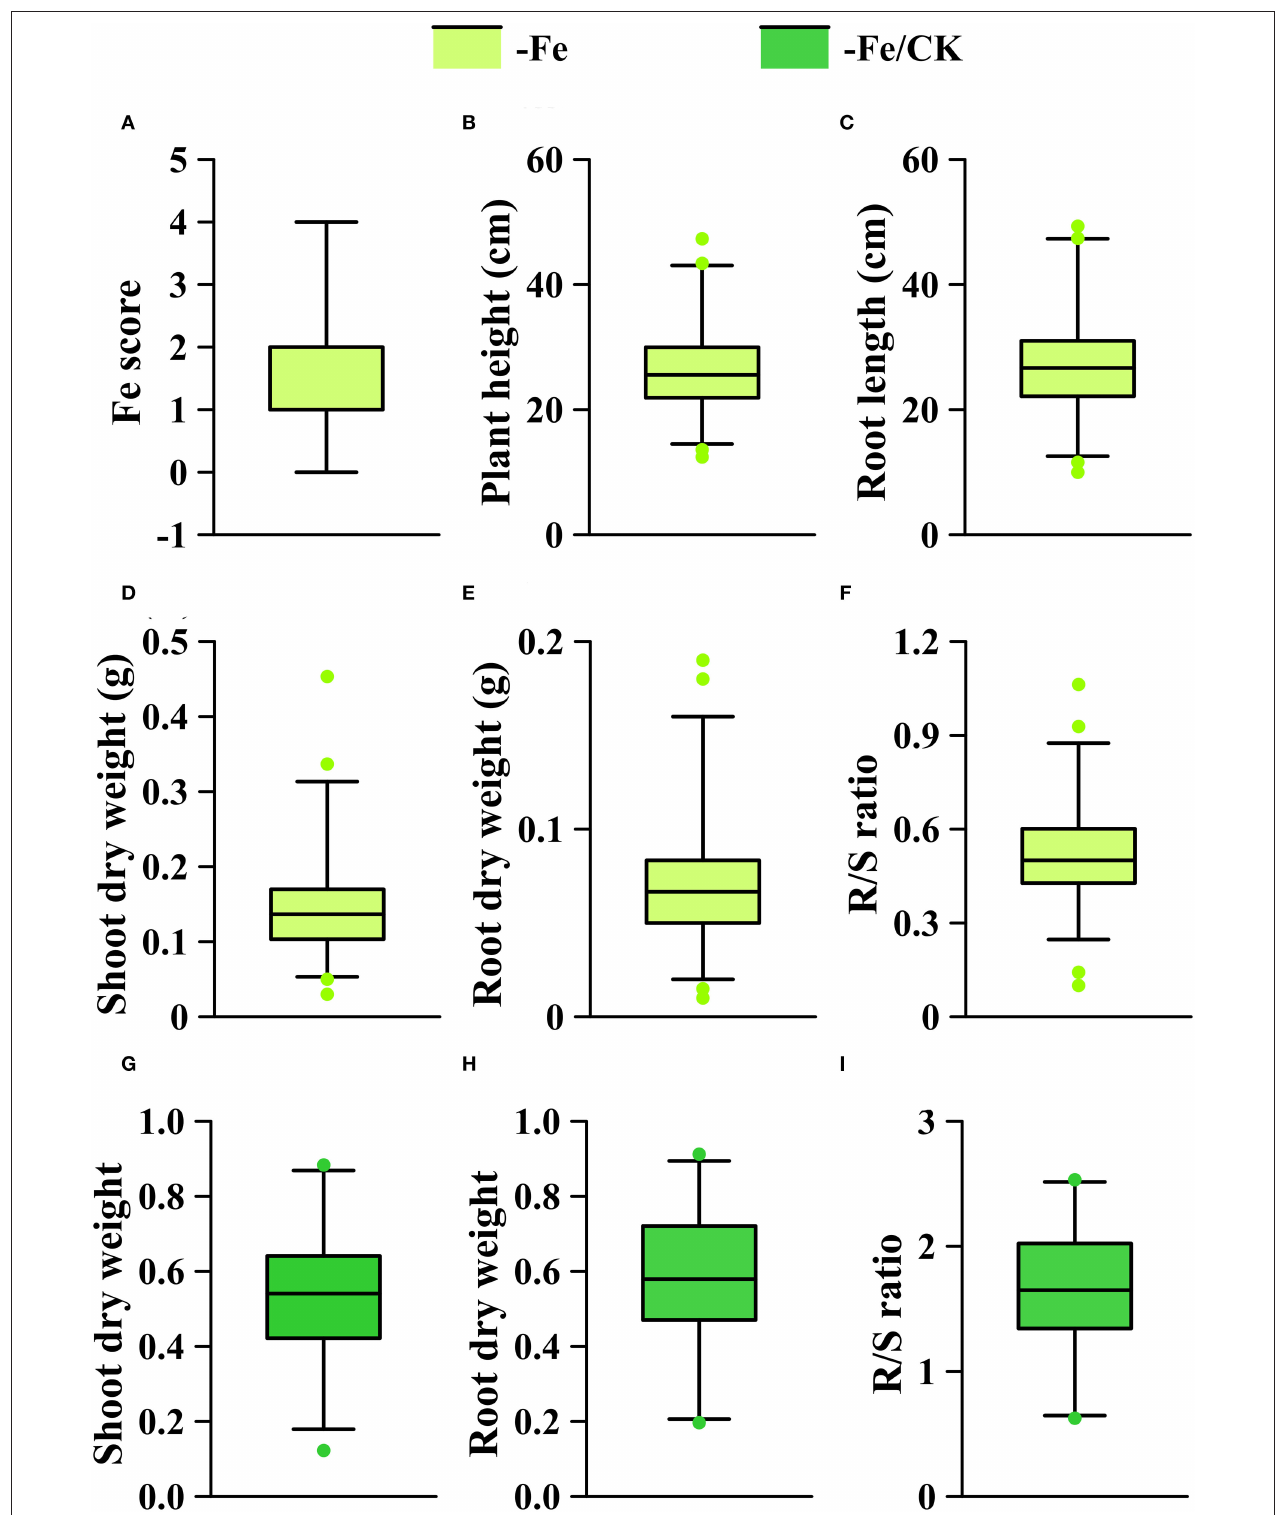
FIGURE 4 | Phenotypic distribution of each trait under different conditions (-Fe, -Fe/CK) in the GWAS panel. (A) Fe score; (B) plant height; (C) root length; (D,G) shoot dry weight; (E,H) root dry weight; (F,I) R/S ratio. The solid line in each box represents the median values. The upper and bottom lines represent the 99th and 1st percentiles, respectively, and the top and bottom edges of each box represent the 75 th and 25 th percentiles, respectively. The solid dots represent outliers.